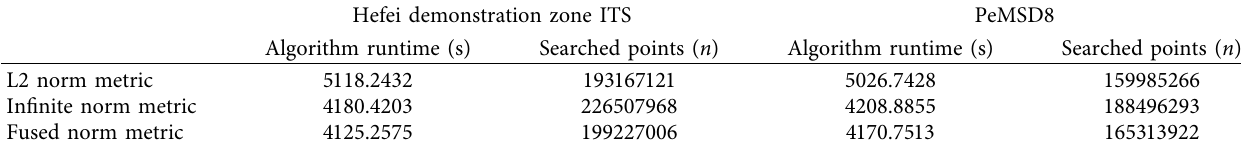
Table 3: Running time and search points of the C-C method under each measurement